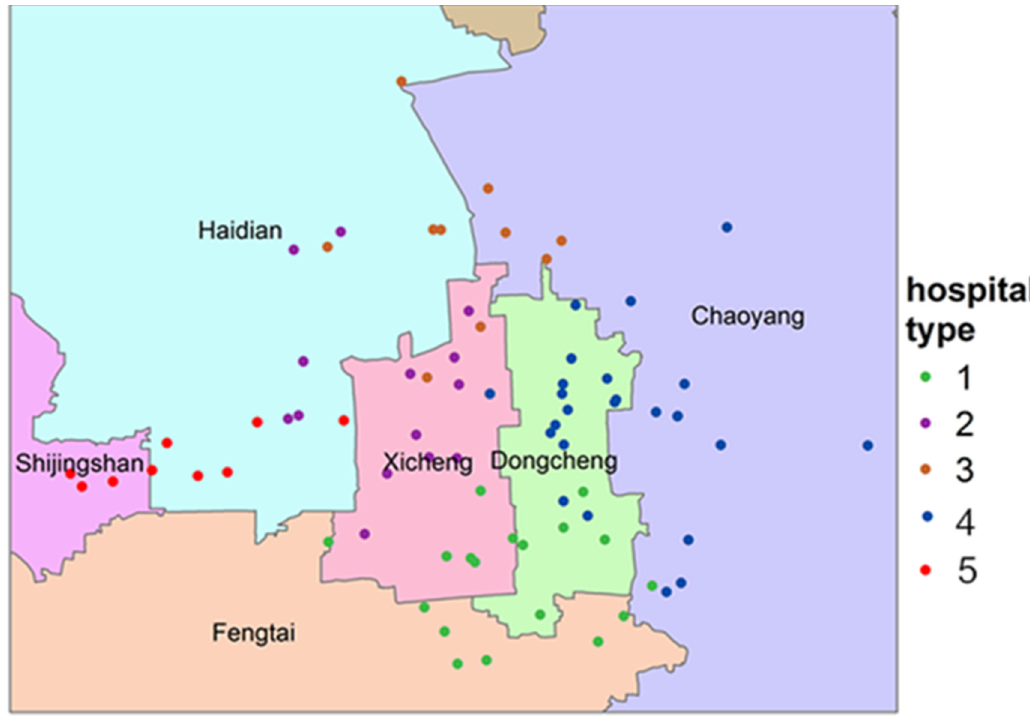
Figure 8. Classification result of 78 hospitals.